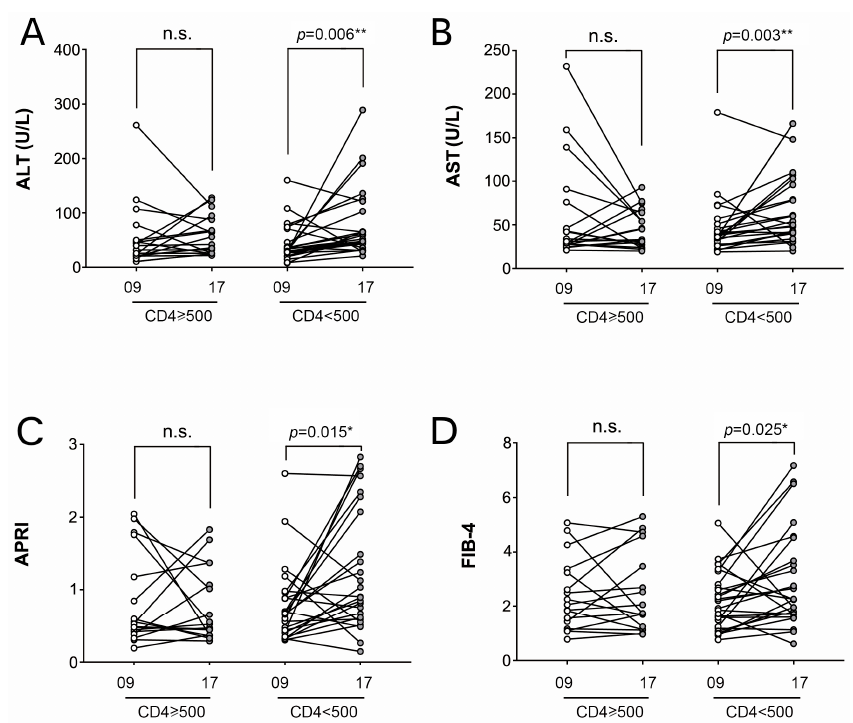
Figure 4. Comparison of variations of AST, ALT, APRI, and FIB-4 values between different CD4+ T cell subgroups from 2009 to 2017. ( A ) ALT, ( B ) AST, ( C ) APRI, and ( D ) FIB-4. (*, p < 0.05; **, p < 0.01; ***, p < 0.001). Table 2. Mortality rates in HCV mono-infection and HCV/HIV coinfected patients from 2009 to